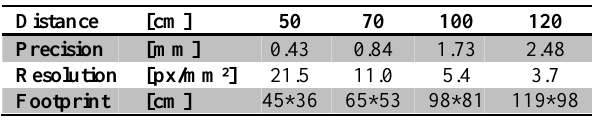
Table 1: Theoretical approximate precision in object space, resolution and footprint size for different acquisition